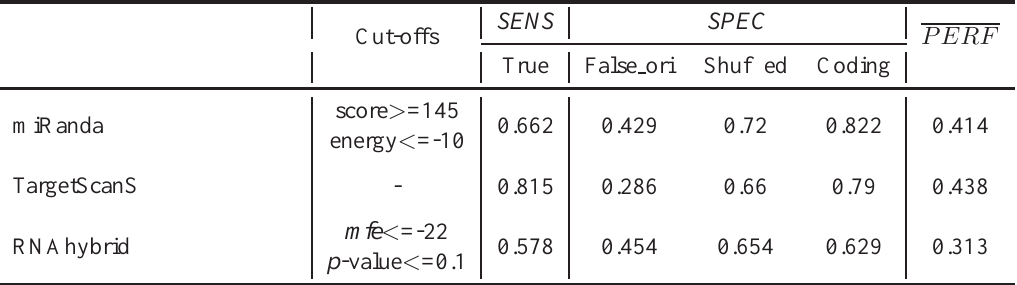
Table 2: Performance of individual algorithms. The last column shows the average performance over the different sets. In order to assure that the results can be compared to that in Table 3,4,5, the shuffled set is listed but not used in the calculation of the average performance in this table.